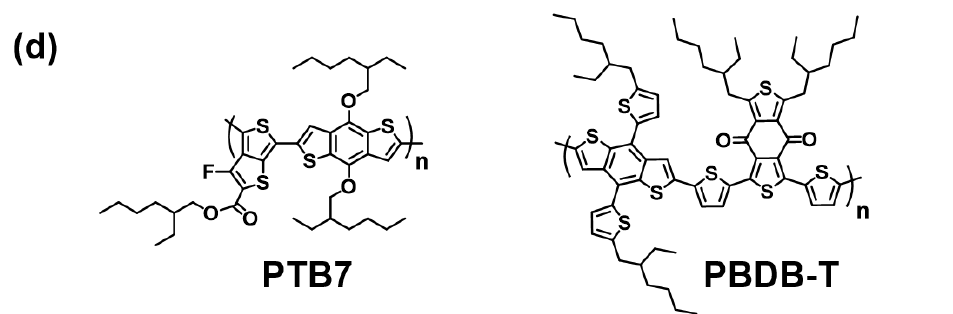
Figure 1. Typical structure of OPV device with BHJ layer ( a ), illustration of selective extraction method and subsequent analysis of donor/acceptor blend films ( b ), and chemical structures of NFAs ( c ) and donor polymers ( d ).